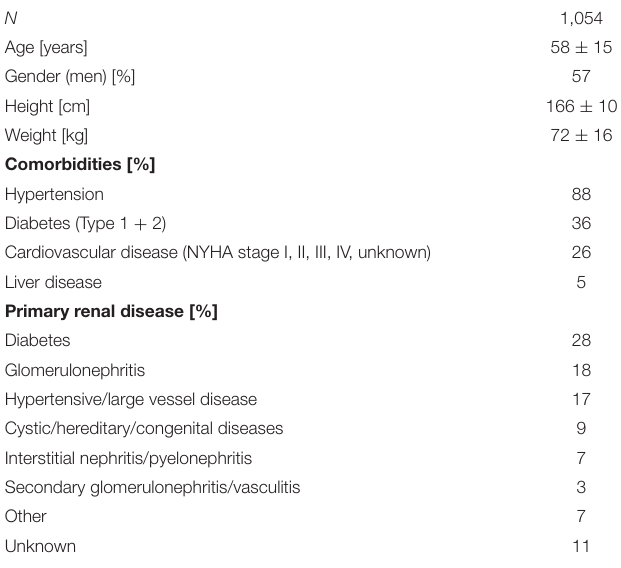
TABLE 1 | Patient